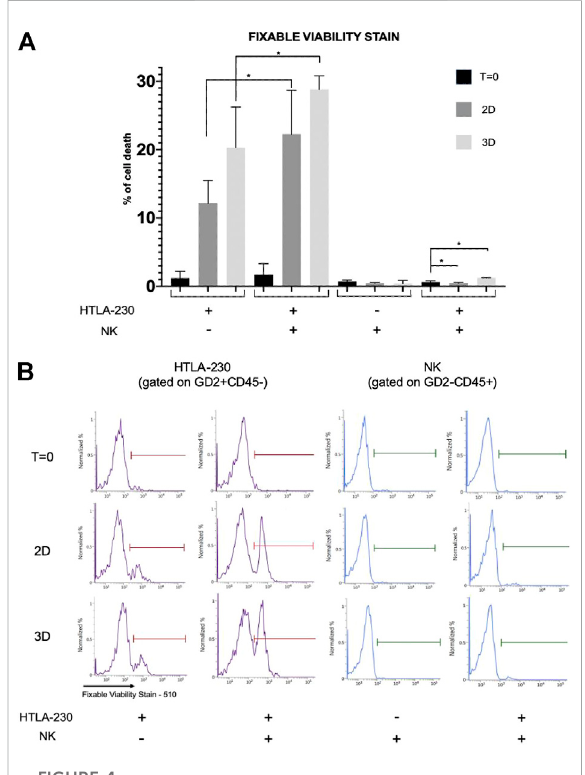
FIGURE 4 ViabilityassessmentofNBandNKcellsin2Dand3Dcultures. (A) Percentage of dead NB or NK cells (i.e., Fixable Viability Stain 510 positive cells) recovered from 2D cultures or 3D alginate spheres, both in monoculture and coculture, gated on GD2+CD45 − and CD45+GD2 − , respectively. Mean fl uorescence intensity with 95% CI is reported ( n = 4, * p < 0.05). (B) Representative